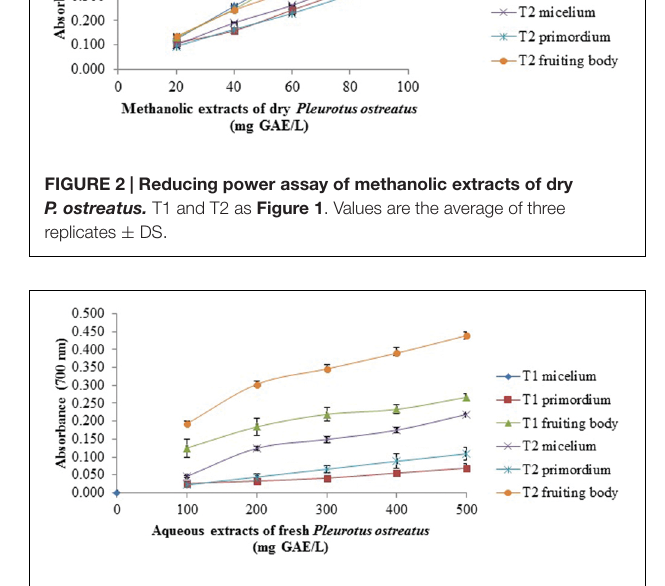
FIGURE 3 | Reducing power assay of aqueous extracts of fresh P. ostreatus. T1 and T2 as Figure 1 . Values are the average of three replicates ± DS.